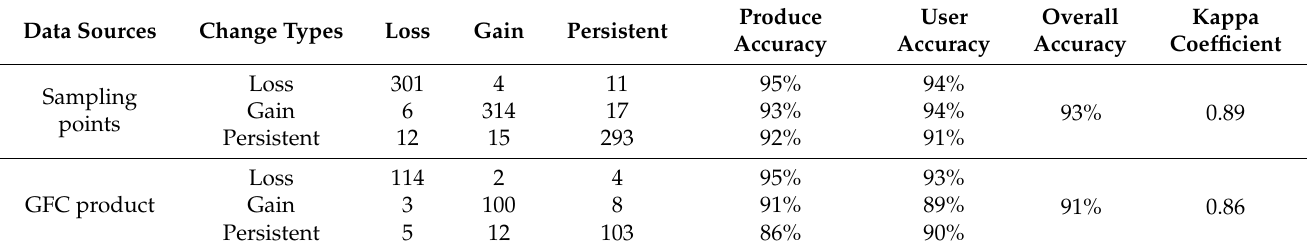
Table 3. Accuracy assessment confusion matrix for forest loss and gain classification results. Note: the pixel values were compared for the GFC